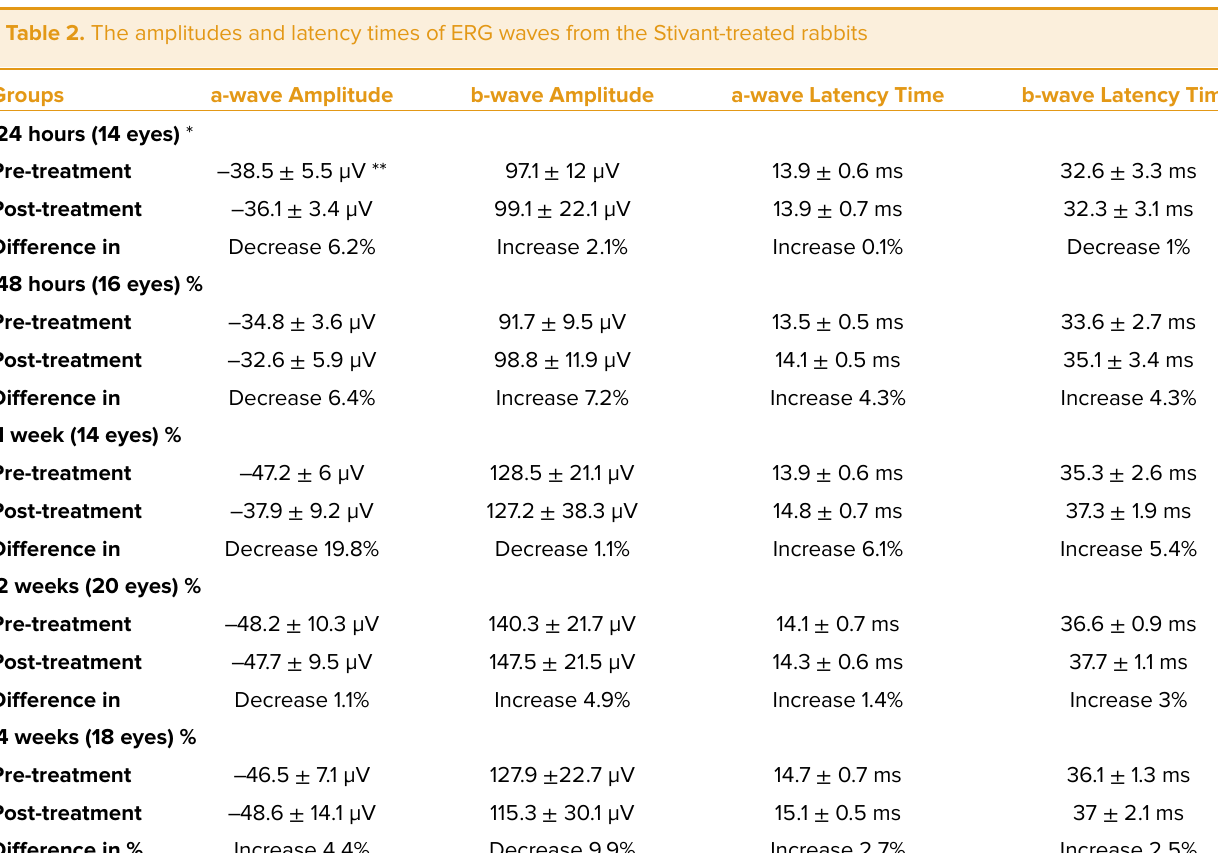
Table 2. The amplitudes and latency times of ERG waves from the Stivant-treated rabbits